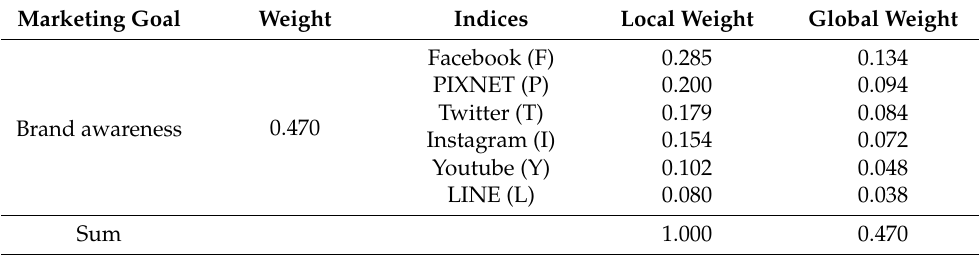
Table 2. AHP brand awareness and complimentary social media analysis.